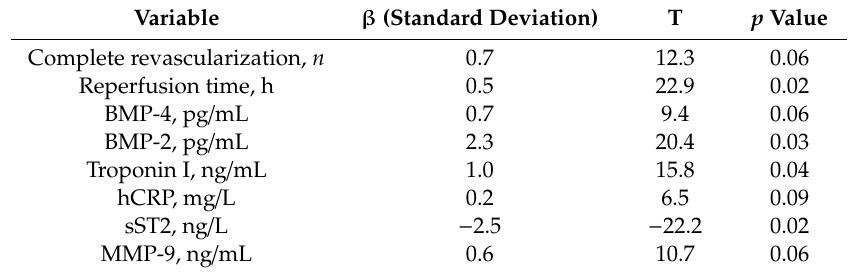
Table 3. Summary of multiple linear regression of reperfusion time, complete revascularization, level of troponin I, sST2, hCRP, MMP-9, BMP-2 and BMP-4 and diagnosis on adverse